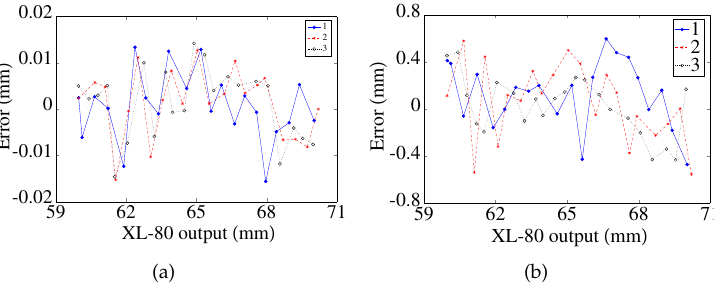
Figure 11. ( a ) Nonlinearity with laser beam pointing control; ( b ) Nonlinearity without laser beam pointing